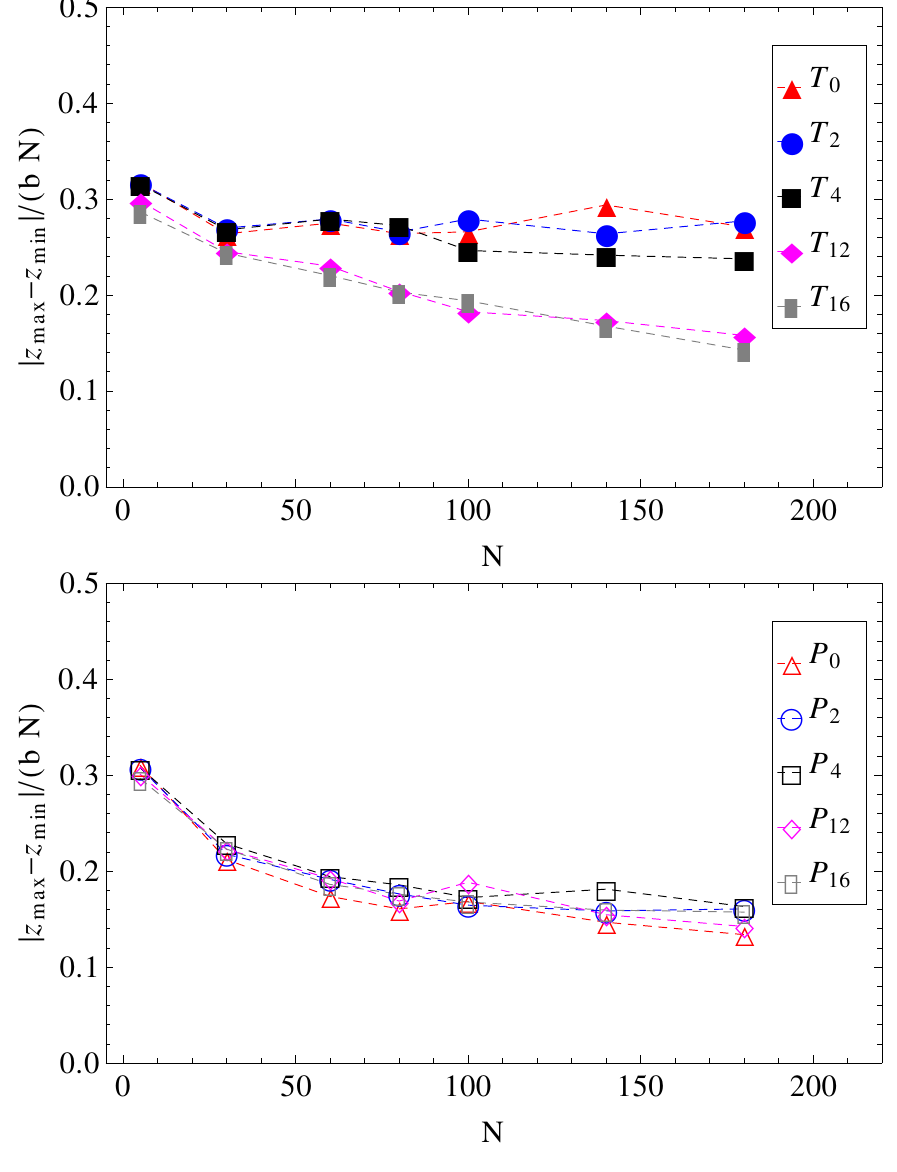
Figure 8. Projections of charged chain extension on the z-axis, normalized by average bond length b , and chain length N , as a function of chain size (for legend, see Figure